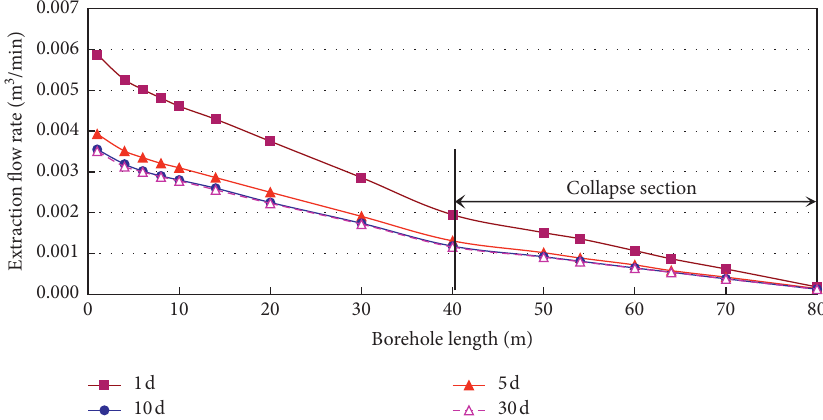
Figure 12: The drainage flow distribution of collapsed hole along the borehole